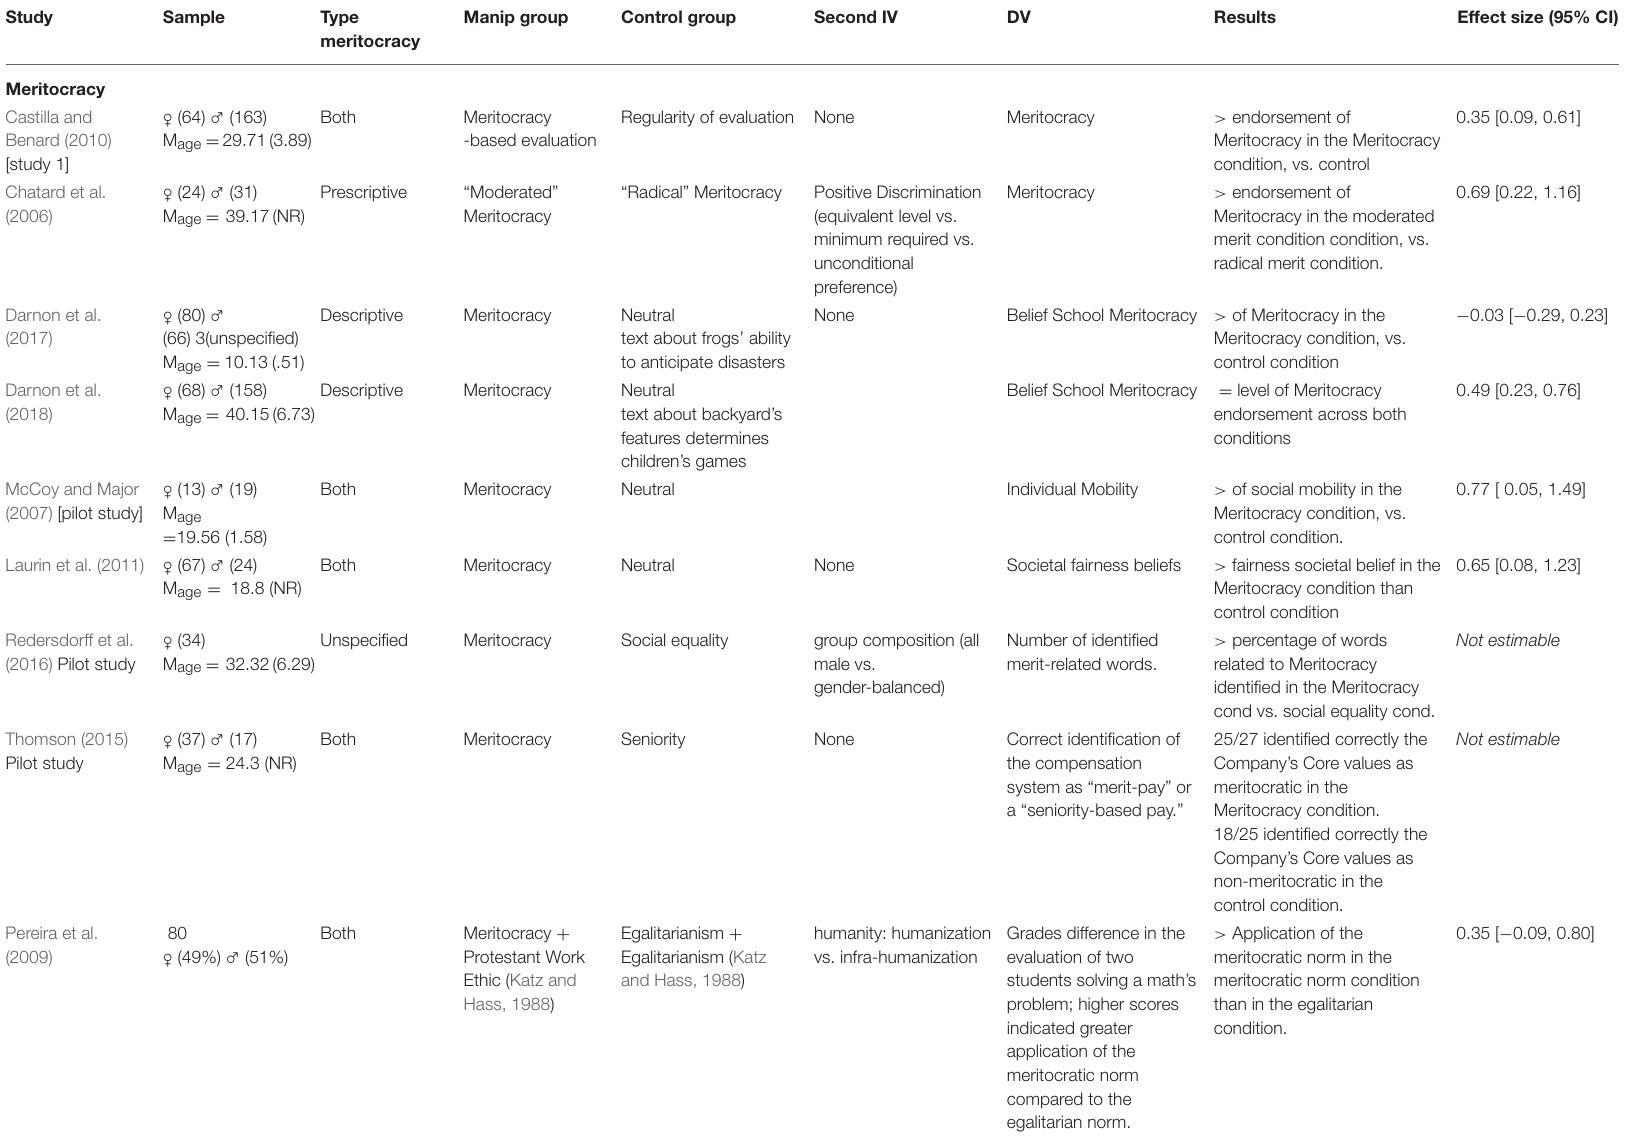
TABLE 1 | Summary of study characteristics and construct salience (MS) results and effect